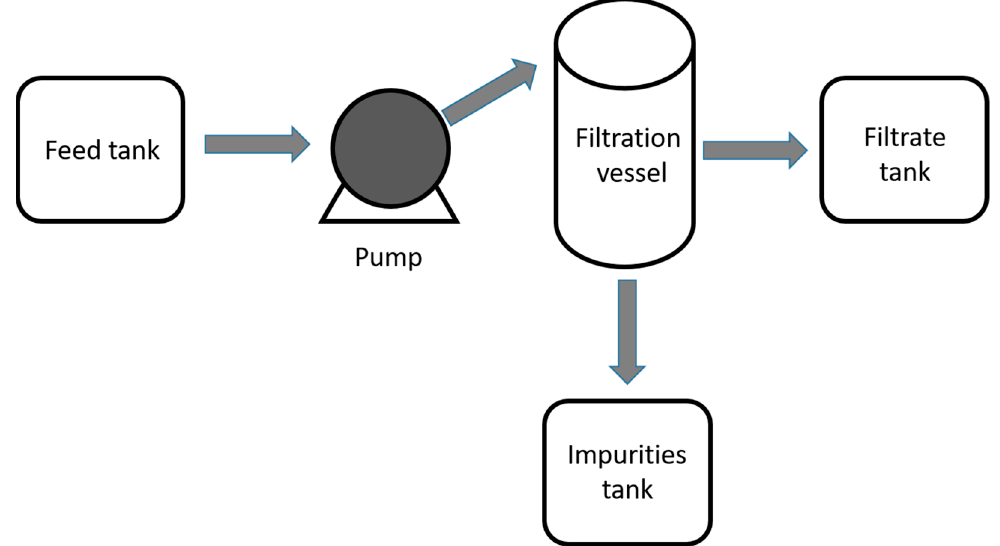
Figure 3. Schematic setup of laboratory filtration unit for separation of oil from oil/water mixture.